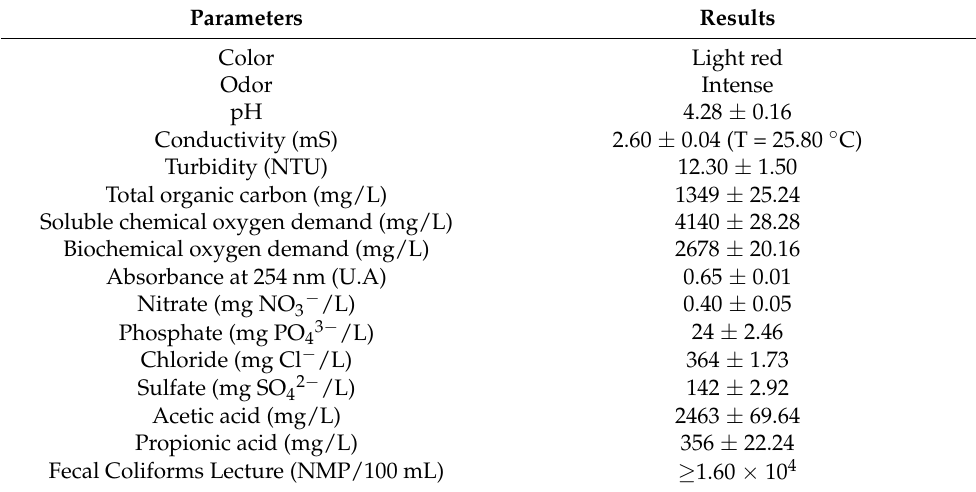
Table 1. Parameters of composite